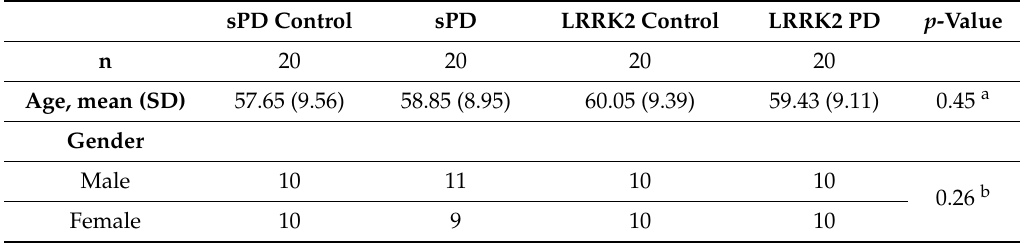
Table 1. Multi-group comparison of available demographic